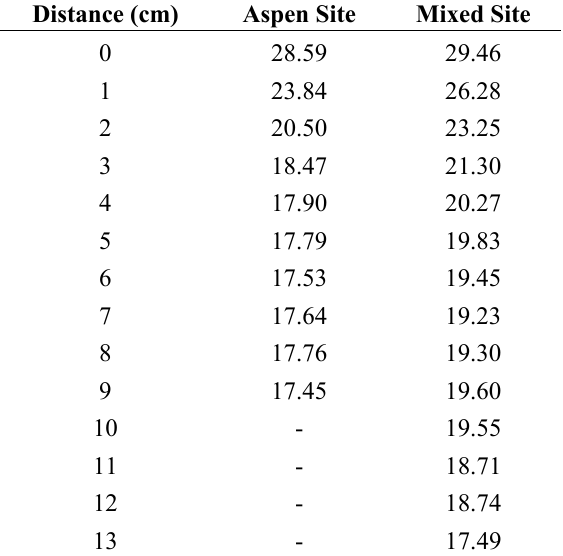
Table 1. Mean microfibril angle (degrees) at given distances from pith for trembling aspen trees originating from the aspen site (PSP 430) and the mixed site (PSP 434). n = 100 for the aspen site, while n = 50 for the mixed